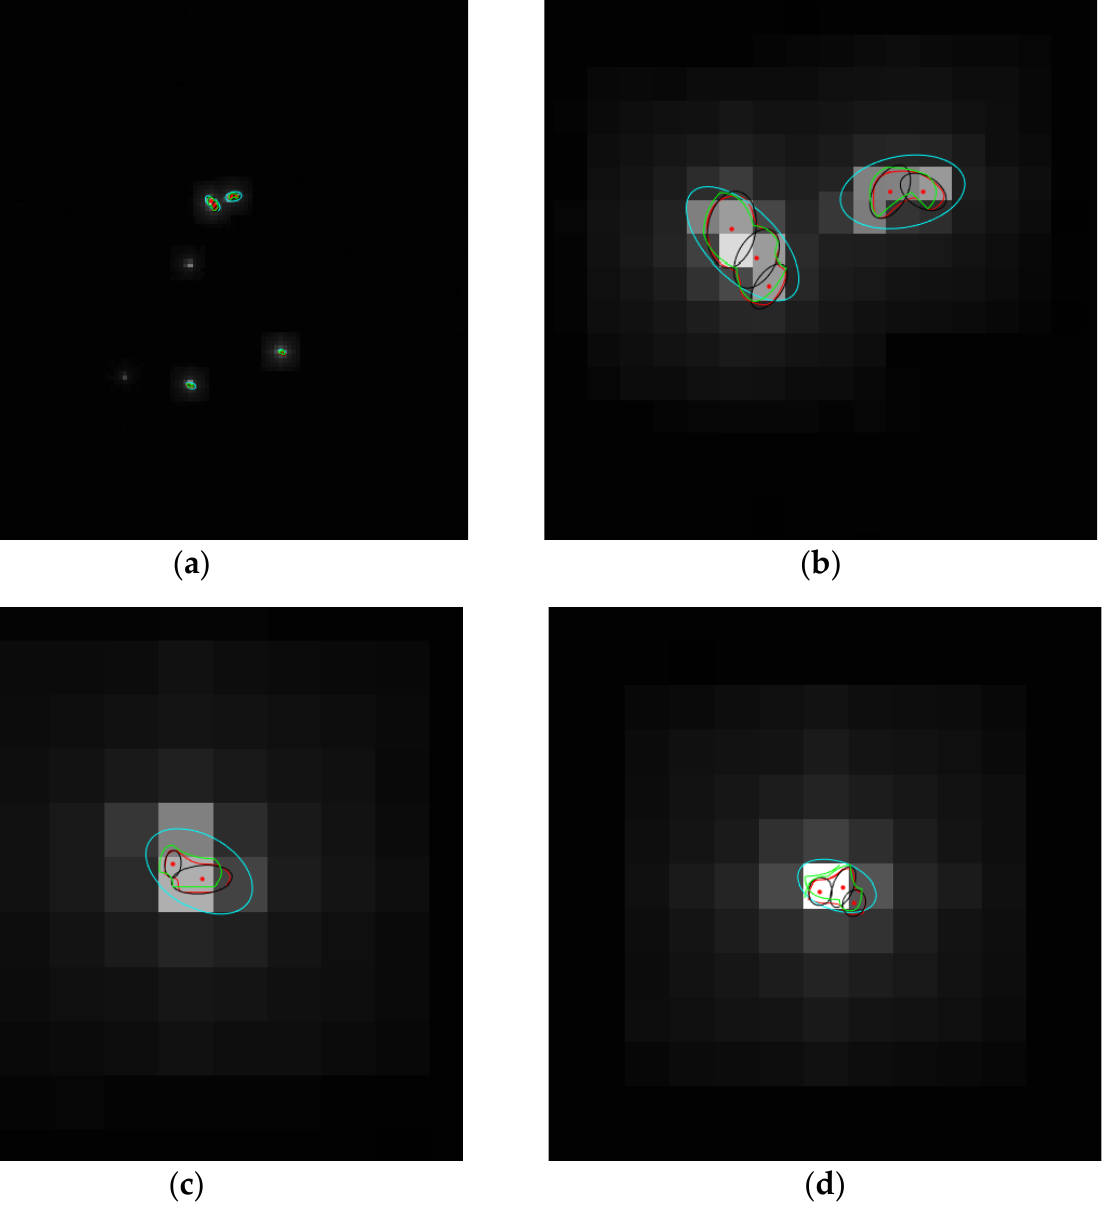
Figure 9. The extension estimation of extended targets under different algorithms for frame 36. ( a )